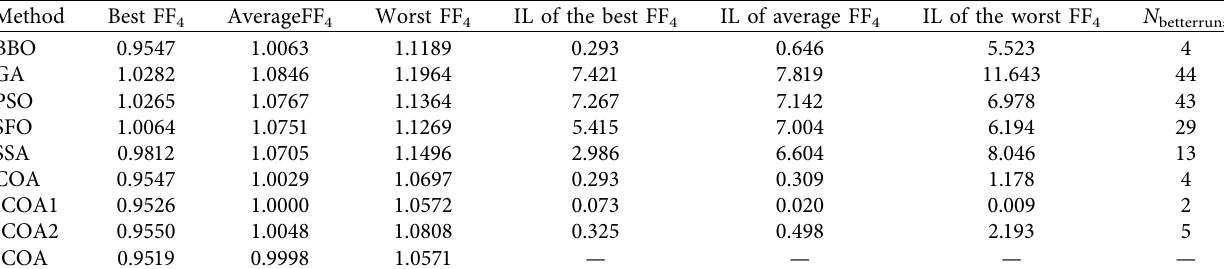
Table 15: The comparison among nine methods of the IEEE 69-bus distribution network for the fourth